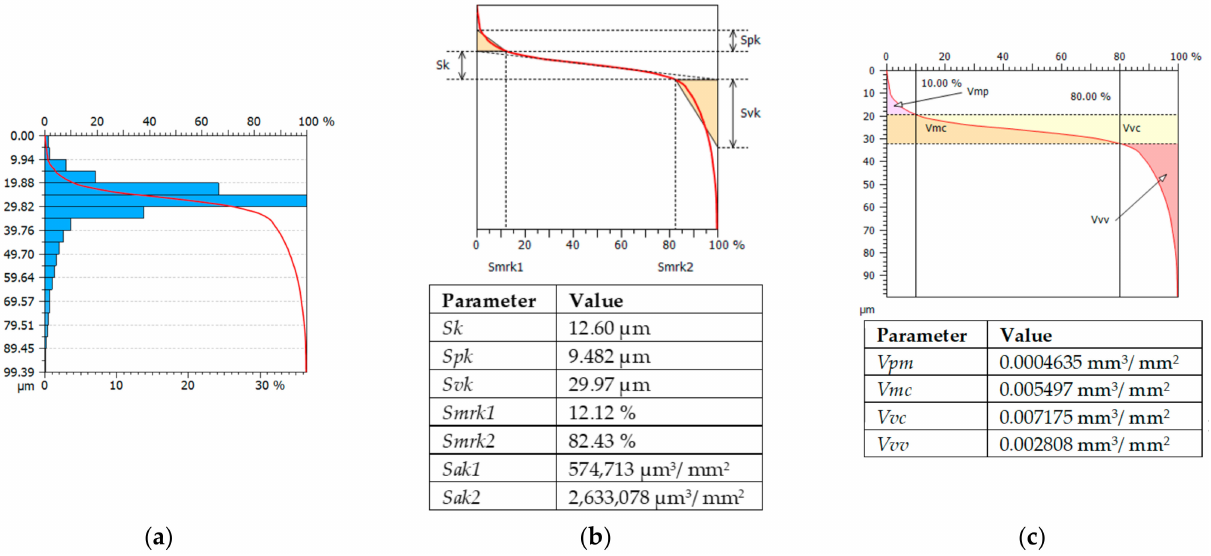
Figure 7. Examples of 3D measurements of surface parameters ( a ) Abott curve, height ( b ) and volume ( c ) test 1 surface